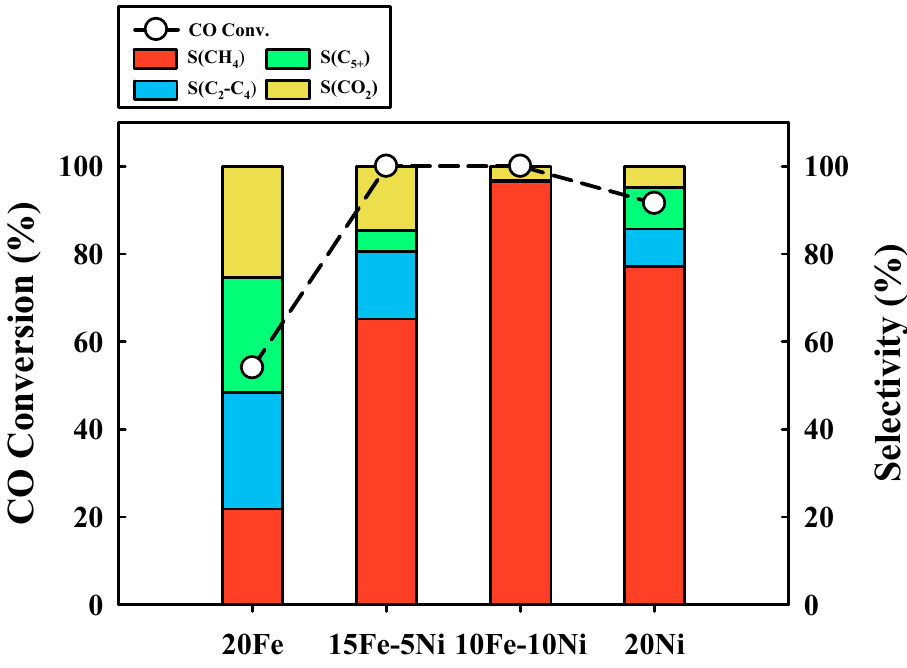
Figure 3. CO conversion and product selectivity in the Ni, Fe, and Fe-Ni catalysts.